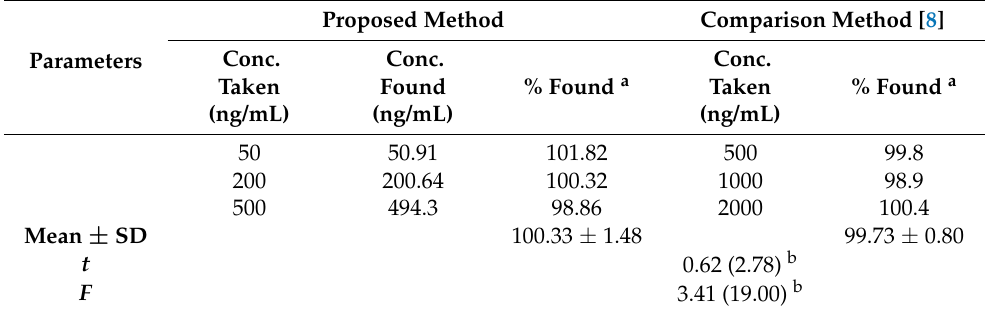
Table 4. Application of the proposed spectrofluorimetric method for the determination of NFZ in tablet and statistical comparison of the data with those obtained by the reported HPLC method.